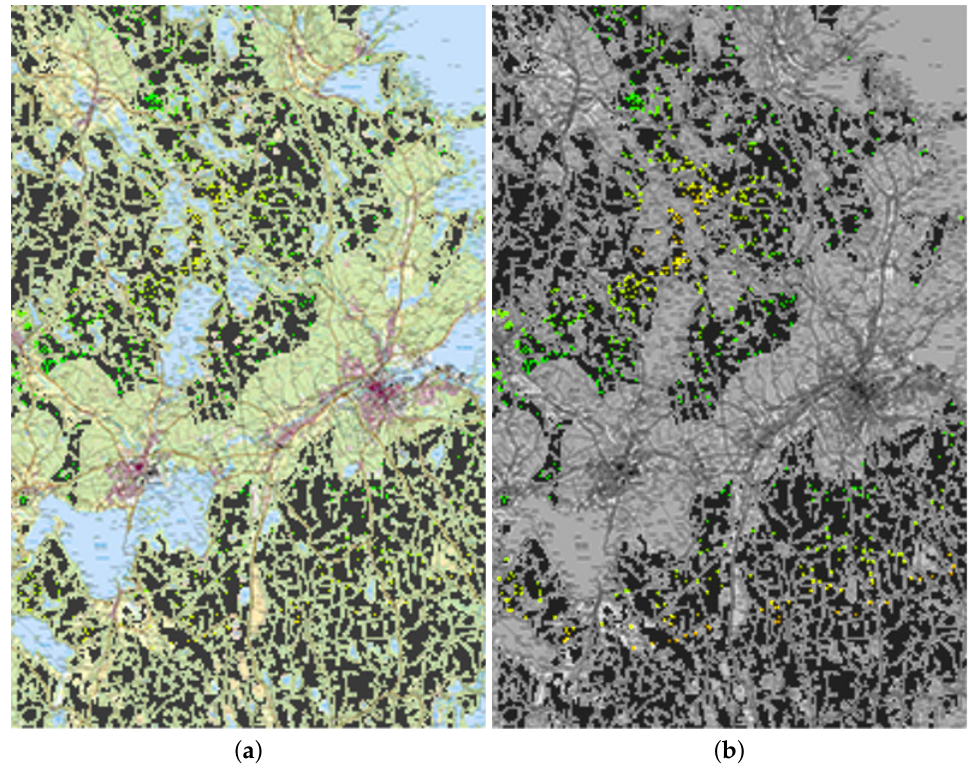
Figure 6. Geomap in default view ( a ) and in desaturated view ( b ). When the number of remaining acceptable alternatives is less than a predefined limit L 1, the attribute space panel is shown. The values of the alternatives in terms of each of the criteria are shown in a parallel coordinates plot (Figure